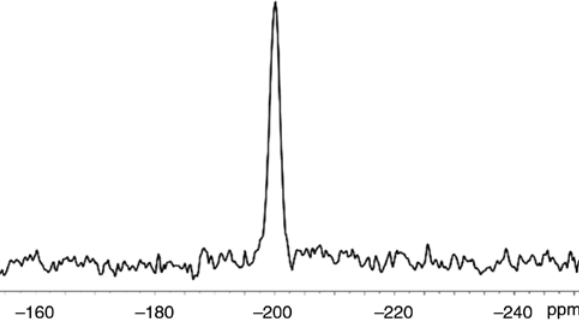
Figure 5: 29 Si CP/MAS NMR spectrum of complex 1 .